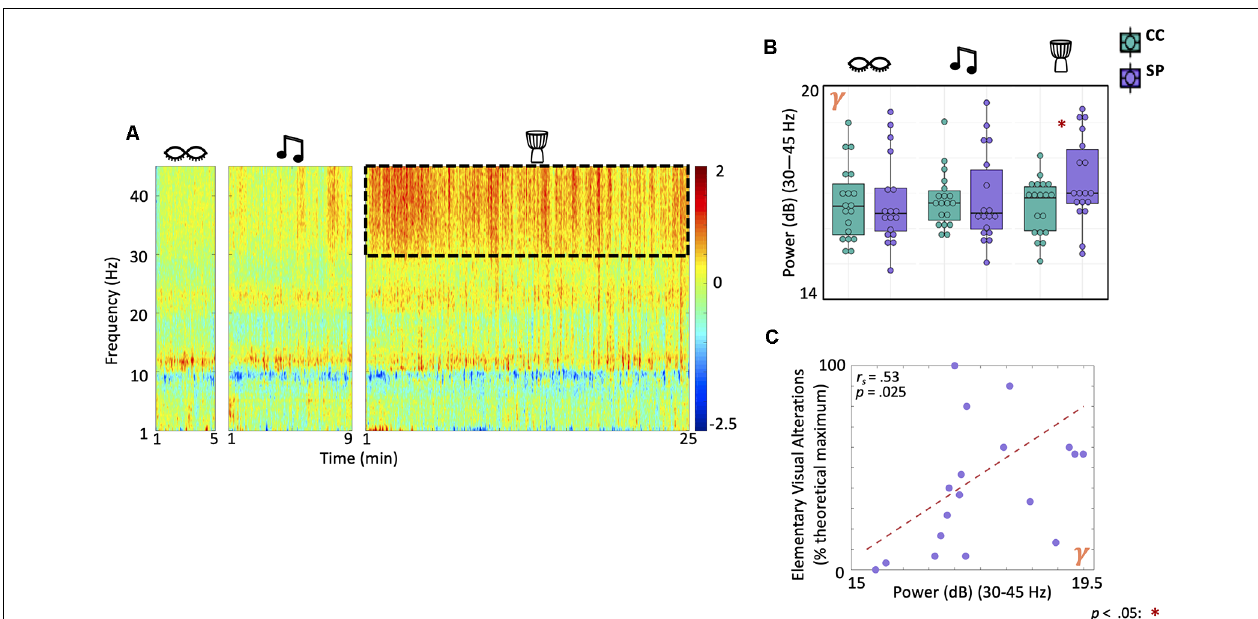
FIGURE 3 | Gamma power is greater in shamanic practitioners during the drumming and correlates with elementary visual alterations. (A) Power spectrogram comparing the difference in power across frequencies (1–45 Hz) between shamanic practitioners (SP; n = 18) and control participants (CC; n = 19) during eyes closed, classical music, and drumming periods. Warmer colors represent greater power in SP and cooler colors indicate more power in CC. The dotted line represents the gamma frequency band (30–45 Hz), which was significantly different between groups during shamanic drumming. (B) Box plots representing the mean absolute power of SP (purple) or CC (green) during eyes closed, drumming, and music. Whiskers represent the lower (25%) and upper (75%) quartiles and the center band of each box represents the median for the group. SP had significantly greater gamma power during the drumming period compared to CC. Significance is indicated by the key in the lower righthand corner of the figure. (C) We correlated absolute gamma power with each of the eight ASC domain scores that were significantly different between groups during drumming in Figure 2A , revealing a positive correlation between absolute gamma power and the degree of elementary visual